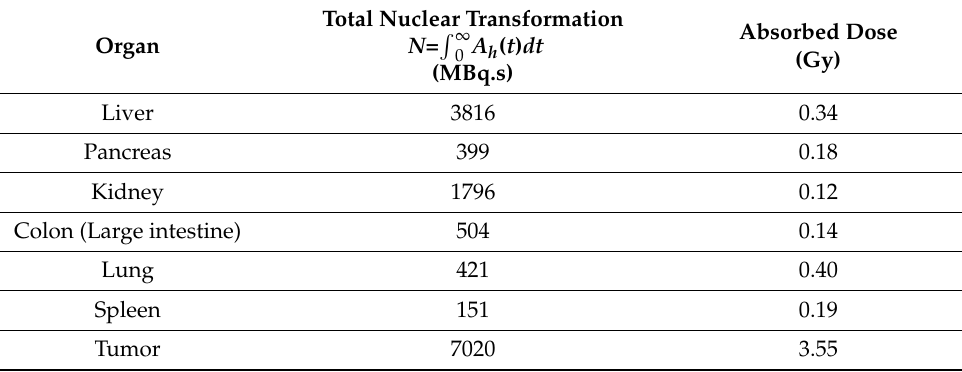
Figure 9. Biokinetic profile of ( A ) I-C19 [ q h ( t ) ] and ( B ) 131 I-C19 [ A h ( t ) ] in Nu/Nu mice with LoVo xenograft tumors after intraperitoneal administration. Table 3. Total nuclear transformations and radiation absorbed dose produced by 5 MBq of 131 I-C19 to the organs and tumor (intraperitoneal administration).